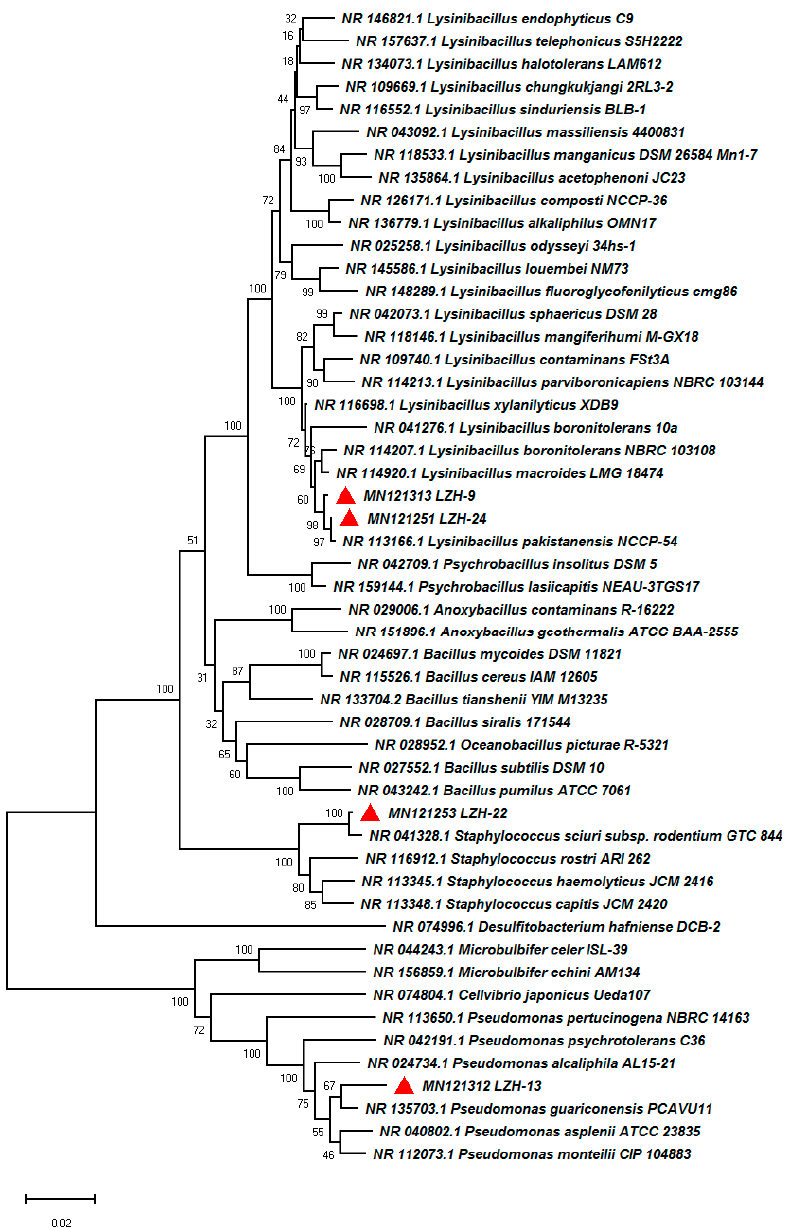
Figure 1. Phylogenetic tree based on 16S rRNA sequences with the Neighbor-joining (NJ) method of LZH-9, LZH-13, LZH-22, LZH-24, and other representative species. Bootstrap values are indicated at each node based on a total of 1000 bootstrap replicates.